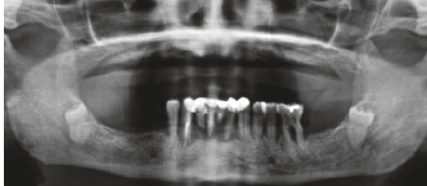
Figure 5: Prior to surgery, a complete lower denture was fabricated in the dental laboratory, made in composite resin with a transparent vacuum-formed